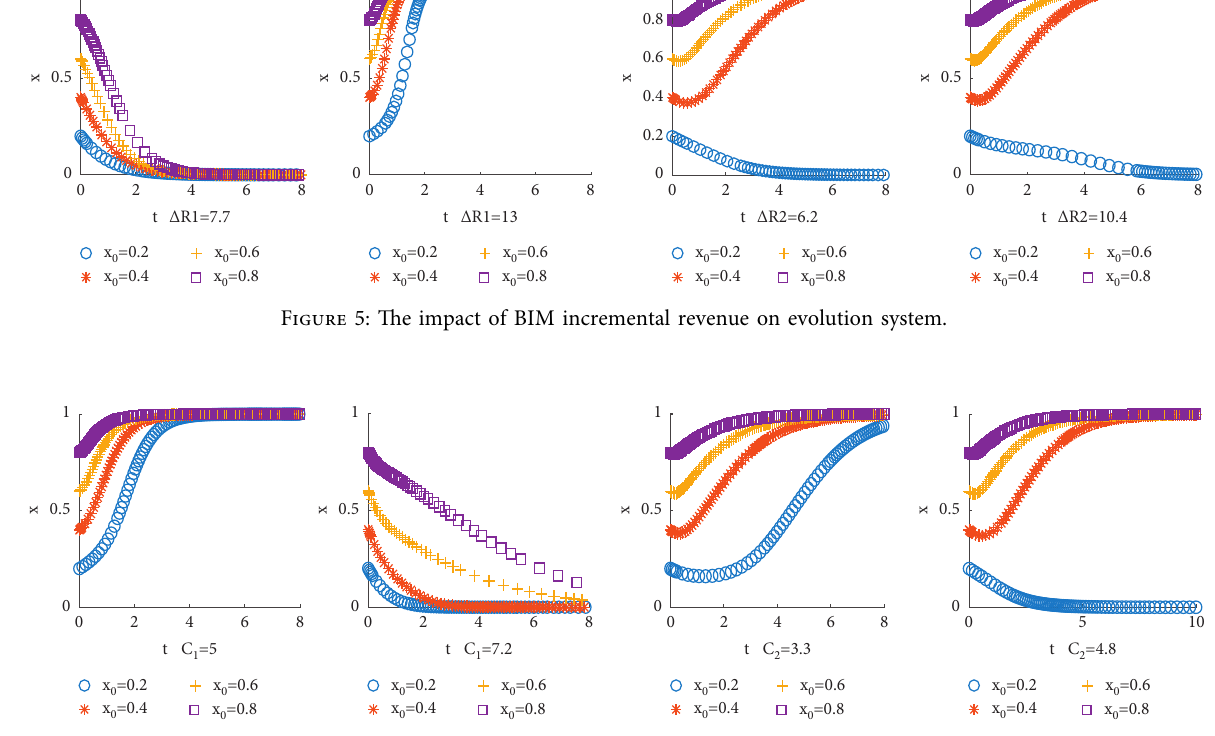
Figure 6: The impact of BIM costs on evolution